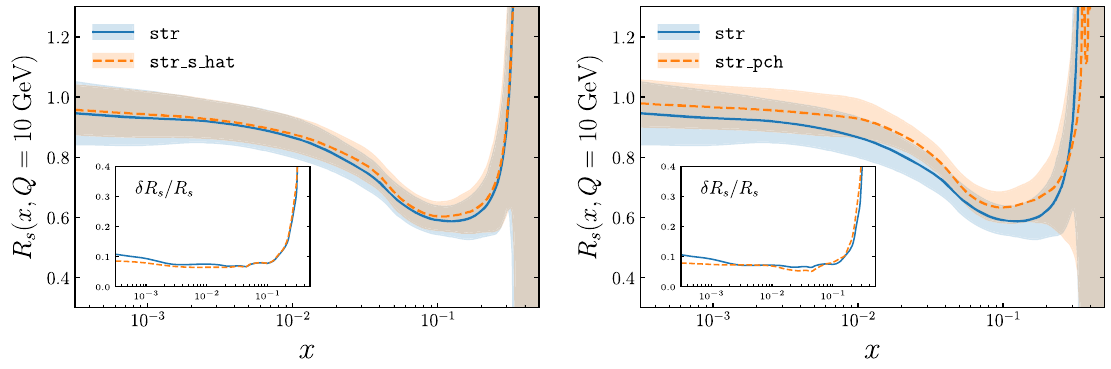
√ ˆ s -dependent ( str_s_hat ) NOMAD dataset (left), and fits with